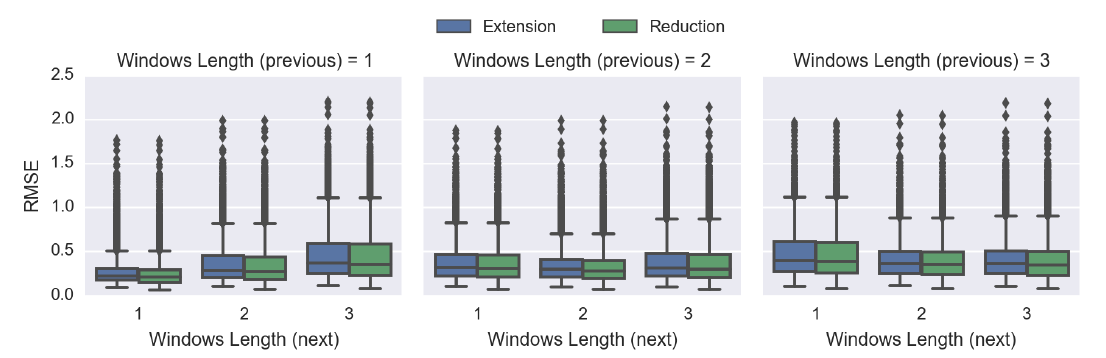
Figure 11. Performance comparisons between different temporal interpolation approaches using the improved IDW: extension (existing) and reduction (proposed) approaches. The vertical axis is the RMSE of the respective (previous and next) windows’ length.